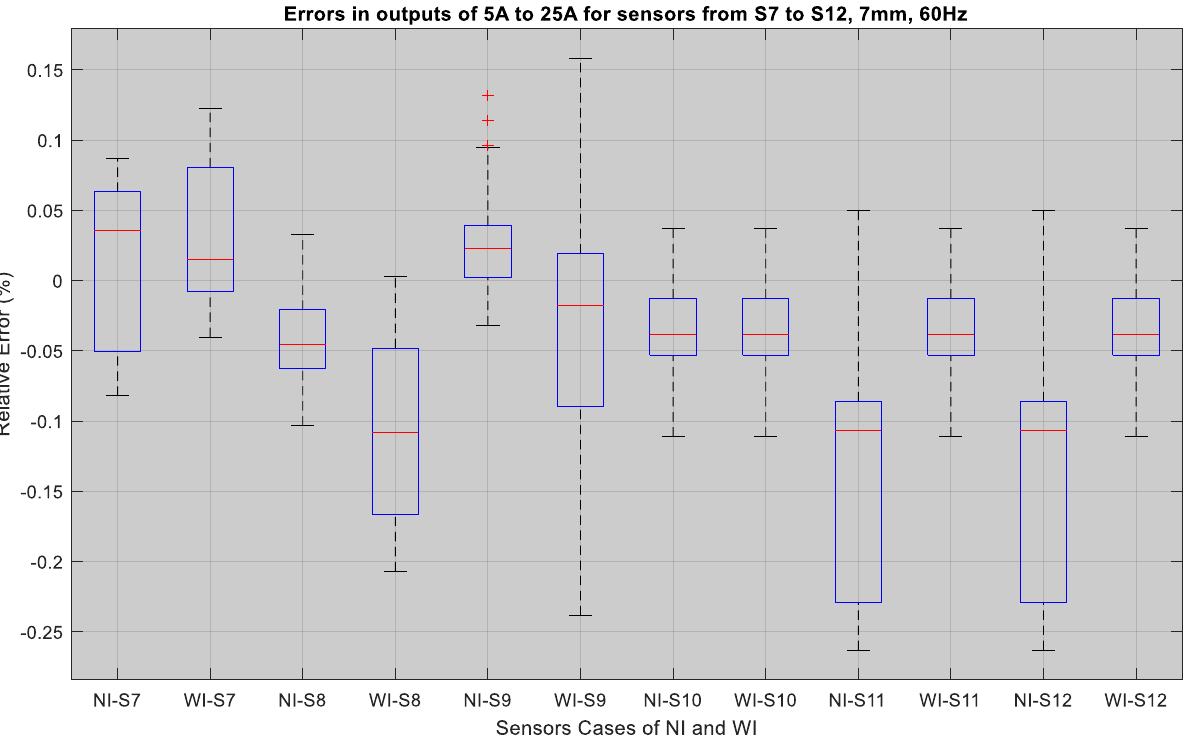
Figure 14. Relative errors in outputs of the sensors S1 to S6: WI and NI case.